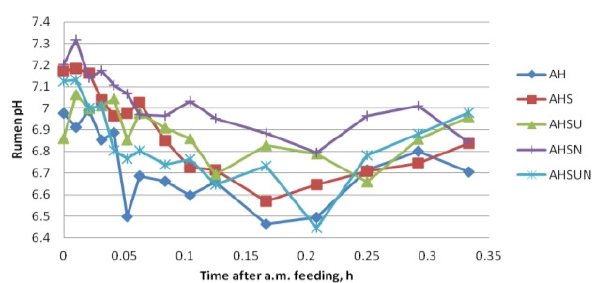
Fig. 1. Effects sesame stover treated with NaOH or urea pluss alfalfa hay on ruminal pH in sheep. Effect of Treatment x Time, p >0.668